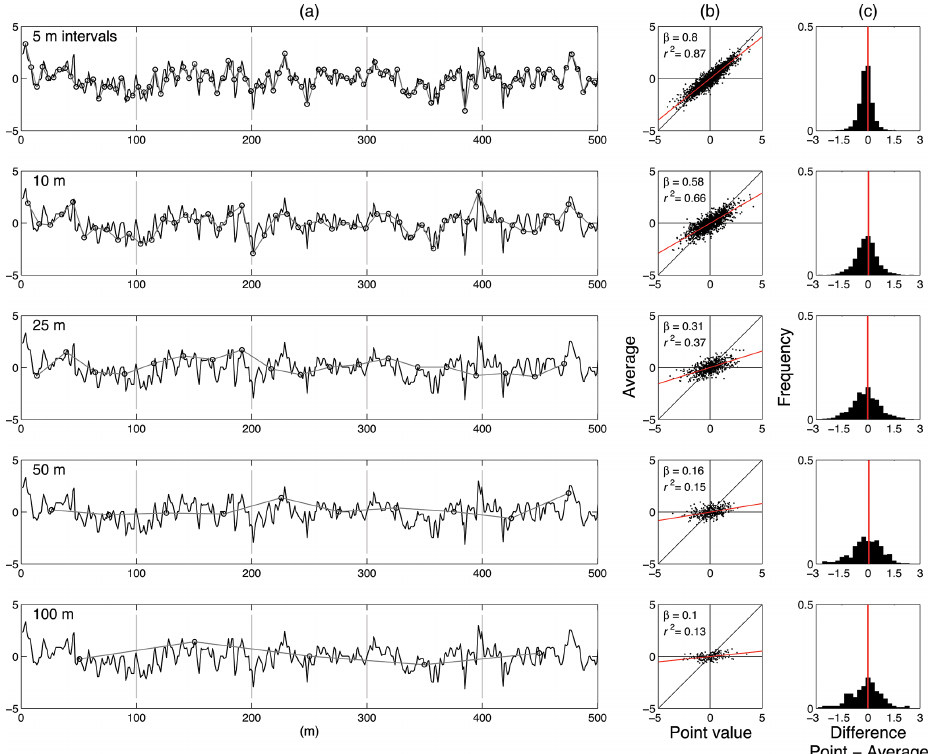
Figure 2. (a) Sample normalized snow depth profile (mean = 0, standard deviation=1) in a forested environment from LIDAR (1m reso- lution) at the Fraser–St. Louis Creek (FS) intensive study area (ISA) of the Cold Land Processes Experiment (CLPX) (Trujillo et al., 2007; Cline et al., 2009). The profile is sampled with regular separations (spacing) of 5, 10, 25, 50, and 100m (from top to bottom, respectively). (b) Average values within sampling intervals (same as in a ) vs. point samples for normalized snow depth profiles in the FS ISA. The red line is a linear regression fit, with slope β and r 2 as indicated in each plot. (c) Histograms of the difference between the point and average values for each of the sampling intervals. The vertical red line marks the mean